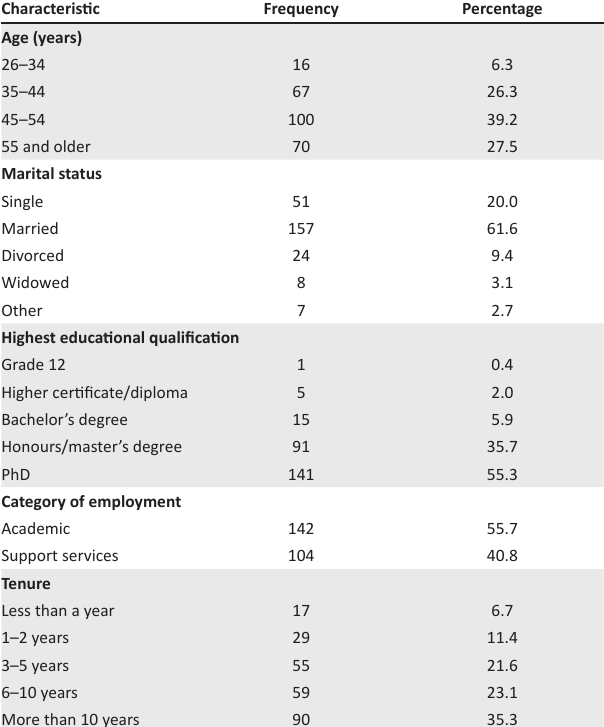
TABLE 1: Biographical details of the sample.